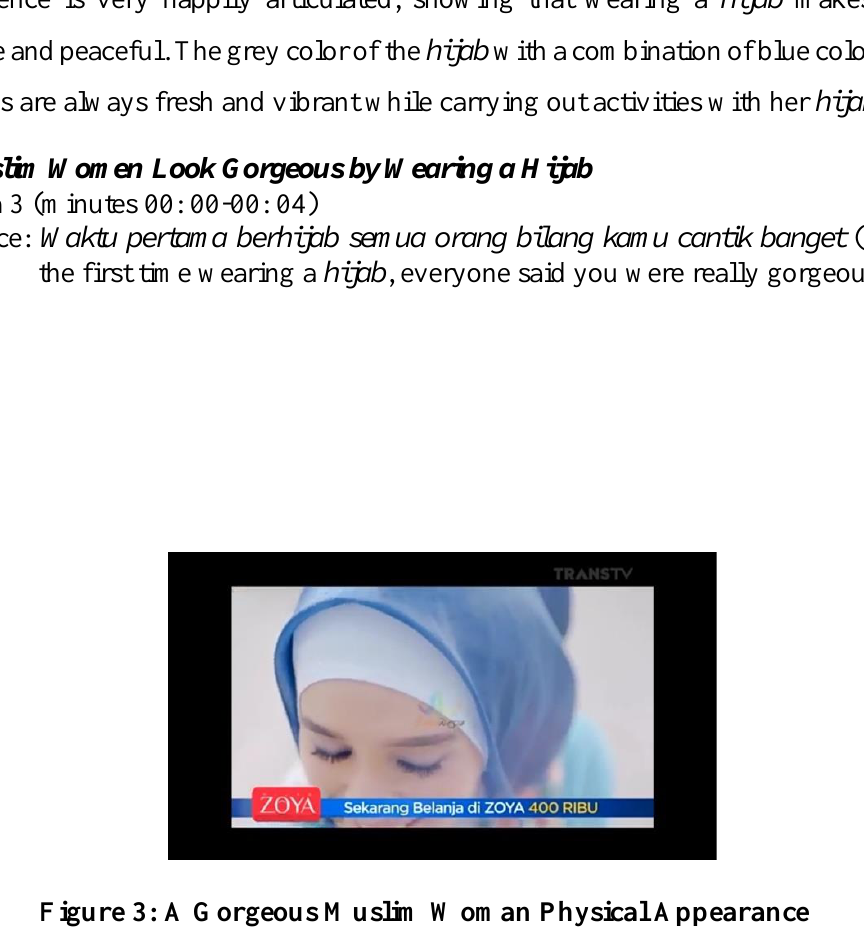
Figure 2: A Glowing Aura Woman Physical Appearance